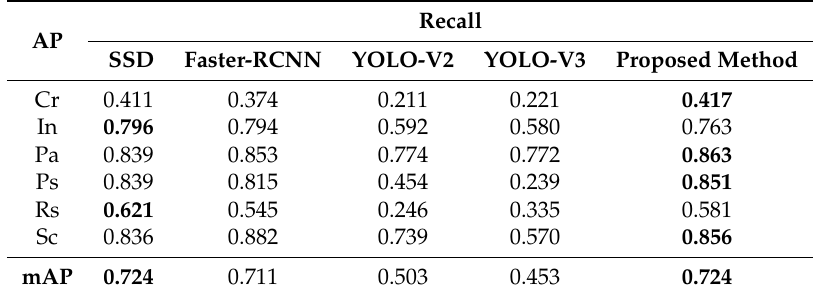
Table 3. Comparison of Average Precision (AP) on NEU-DET dataset. The proposed method performs the highest AP values for four defect categories. The proposed method also provides the highest mAP value. The bold helps to emphasize the highest